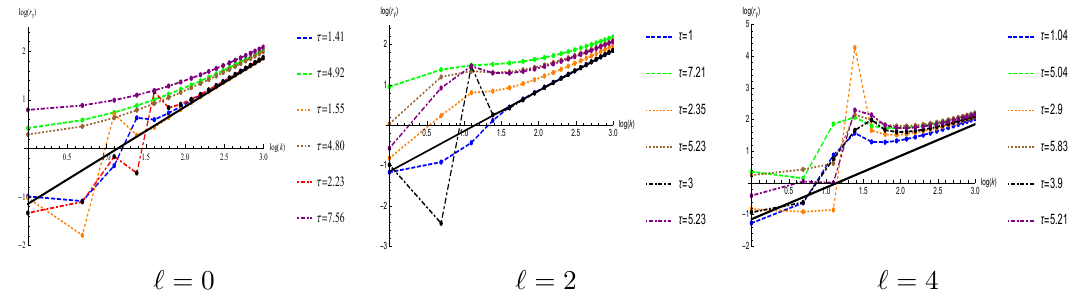
Figure 1 . Plots of log r (cid:13) vs log k for various twists and spins. The solid black line is r (cid:13) = k=(cid:25) . The dashed lines are for d = 3 ; (cid:1) (cid:30) = 0 : 518, the dotted lines are for d = 4 ; (cid:1) (cid:30) = 1 : 28 and the dot-dashed lines for d = 5 ; (cid:1) (cid:30) = 1 : 88.